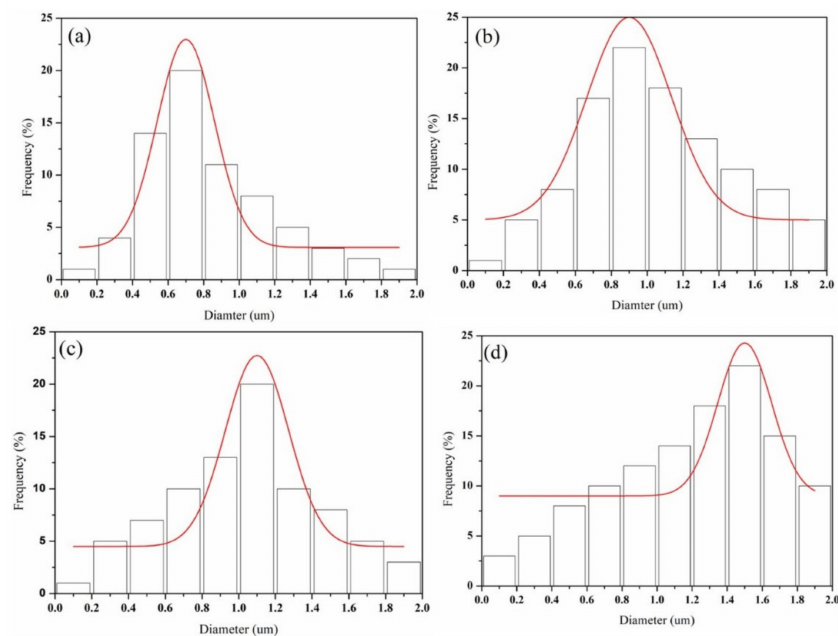
Figure 4. PLA fiber-diameter distribution with di ff erent solution concentrations; ( a ) 8%; average diameter 0.7 µ m, ( b ) 10%; average diameter 0.9 µ m, ( c ) 12.5%; average diameter 1.1 um, ( d ) 15%; average diameter 1.5 µ m with CTAC-MMT.